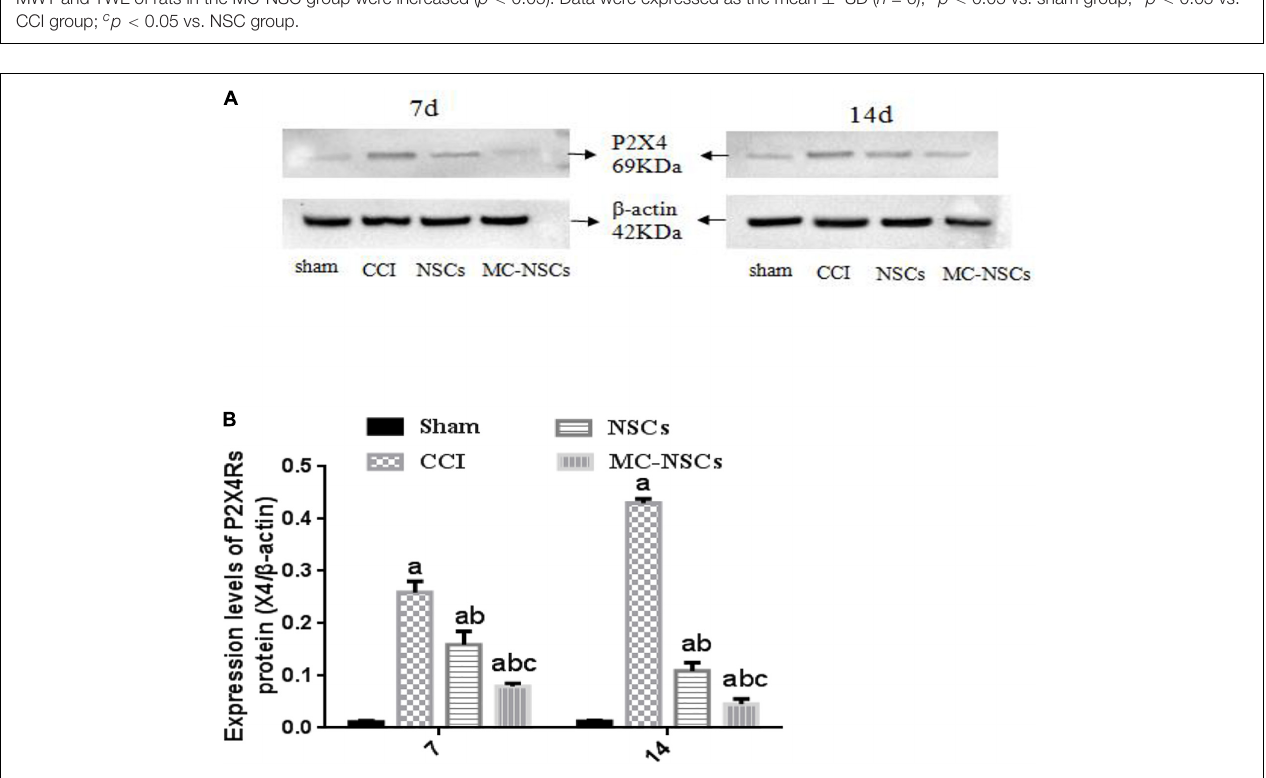
FIGURE 4 | (A) Western blotting was performed to measure the expression of P2 × 4R protein in the L4–5 spinal cord segment tissues in each group. (B) The expression levels of P2 × 4R protein from high to low were found in the CCI, NSC, MC-NSC, and sham groups (all p -values < 0.05). Moreover, in the MC-NSC group, the expression of P2 × 4R protein was decreased on day 14 than that on day 7 ( p < 0.05). Data were expressed as the mean ± SD of three replicates ( n = 6). a p < 0.05 vs. sham group; b p < 0.05 vs. CCI group; c p < 0.05 vs. NSC